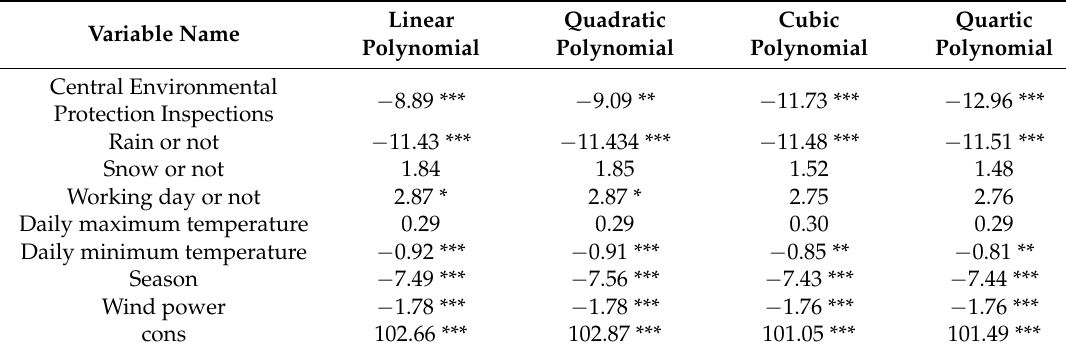
Table 1. AQI regression results.